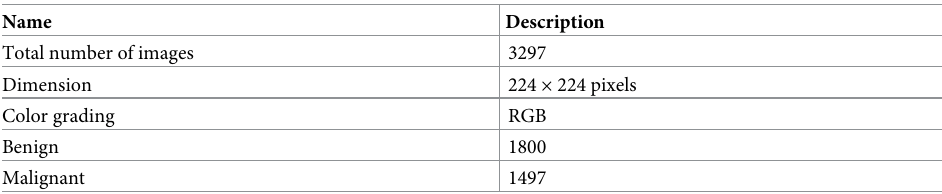
Table 2. Dataset